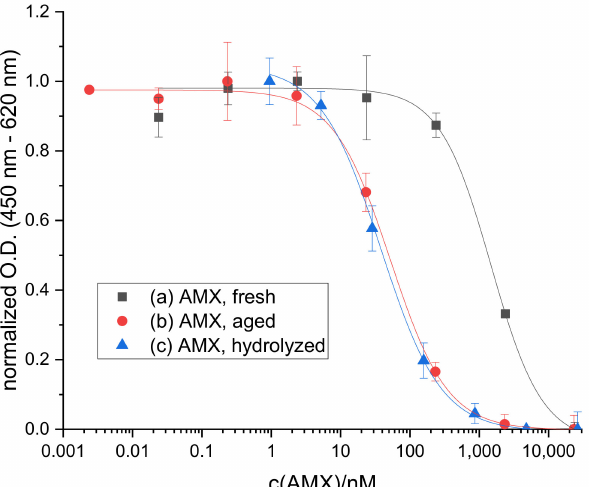
Figure 2. ELISA calibration curves obtained for standard solutions series of AMX after different treatments, (a) freshly prepared (reference), (b) aged for 2 months at 4 ◦ C in a refrigerator, and (c) hydrolyzed during 24 h at 4 ◦ C, also in a fridge. IC 50 values: (a) 1470 ± 120 nM, (b) 52.2 ± 4.4 nM, and (c) 38.1 ± 3.6 nM.